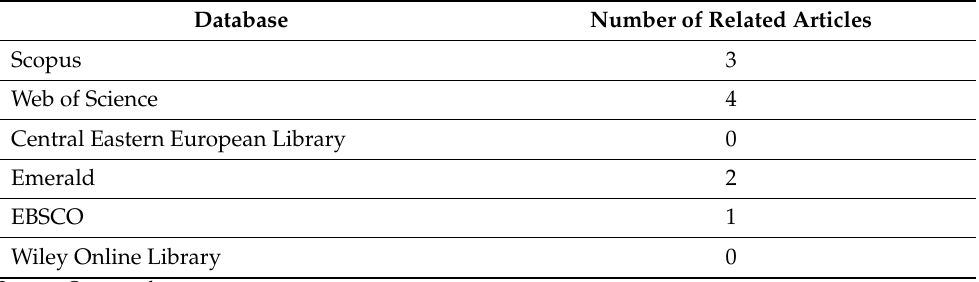
Table 2. The number of articles in presented